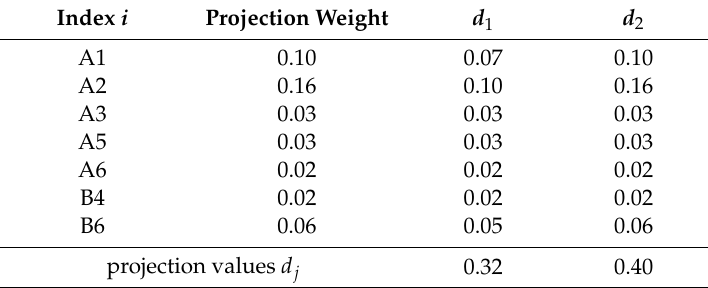
Table 6. Evaluation results of project benefit based on Investors.